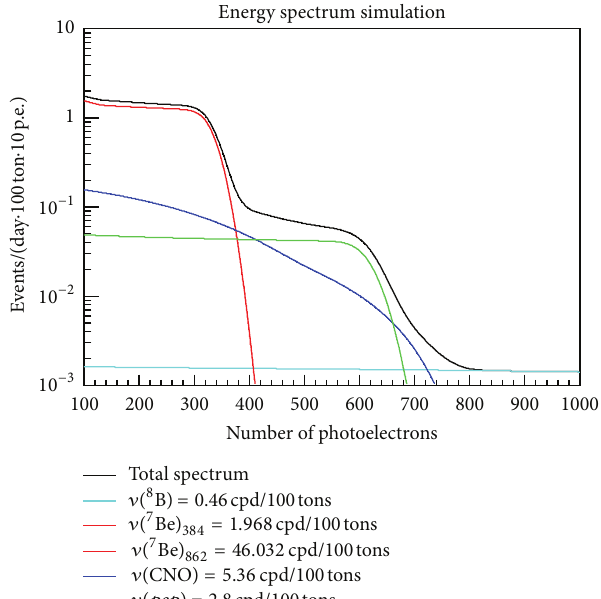
Figure 10: The neutrino-induced electron recoil spectra expected in Borexino.Thetotalratesarethosepredictedbythelatest high-Z solar model [64]. The pep and CNO neutrinos recoil spectra with end points in the region 1.2–1.5MeV are shown. Also the 7 Be neutrinos (measured in [129]), with a count rate about 10 times larger, are shown for comparison. Note that the variable on the 𝑥 -axis is not directly the energy value. Taken from [131].